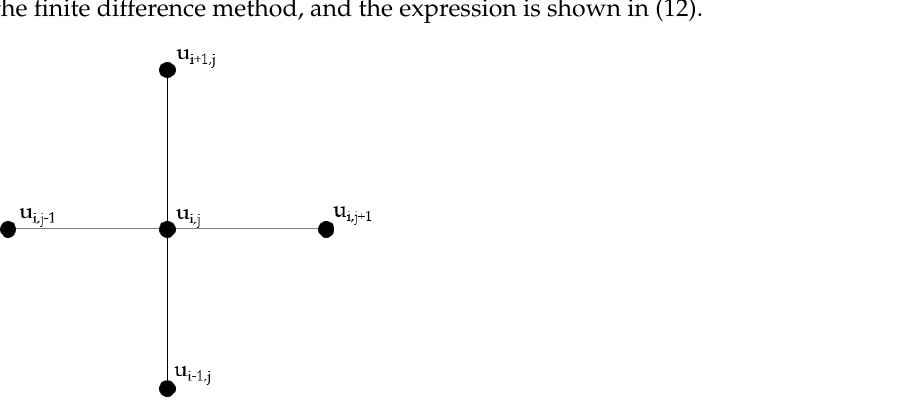
Figure 5. A schematic node-ordering representation for a two-dimensional finite-difference grid